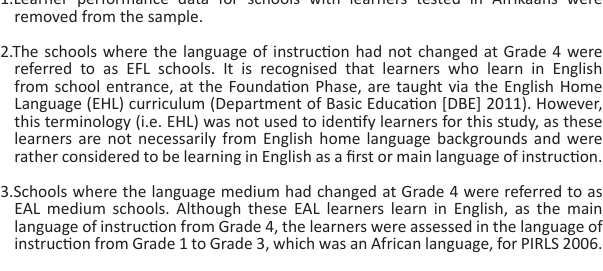
TABLE 1: South African learners at the Progress in International Reading Literacy Study (PIRLS) 2006 international benchmarks. PIRLS 2006 international